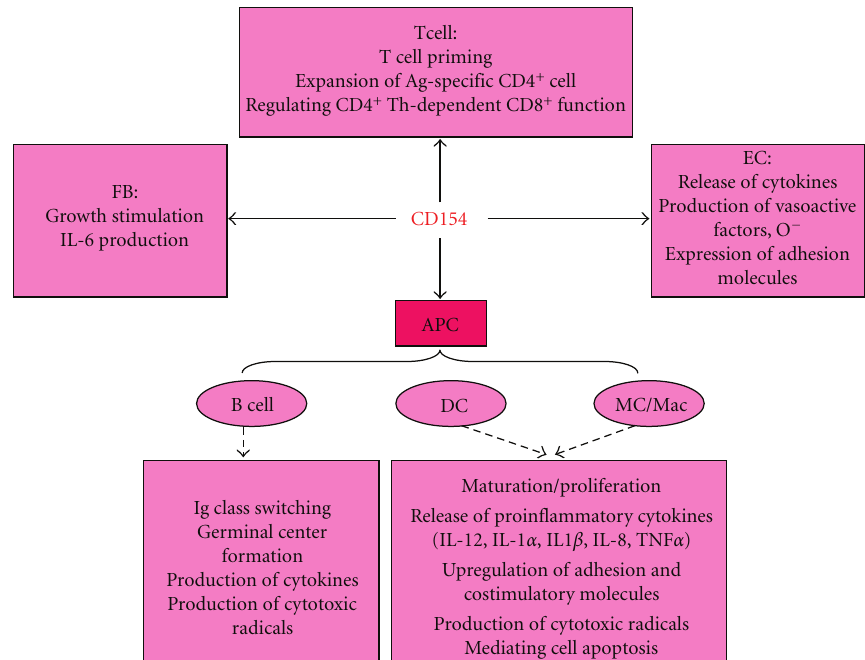
Figure 1: Biological function of the CD154/CD40 interaction. CD154 mediates numerous inflammatory functions on a wide variety of cell types by interacting with its classical CD40 receptor. These include T cell priming, B cell-dependent Ig class switching and germinal center formation, cell proliferation, regulation of apoptosis, release of proinflammatory cytokines, upregulation of adhesion molecules and costimulatory molecules, and production of cytotoxic radicals. FB: fibroblast, EC: endothelial cell, APC: antigen presenting cells, DC: dendritic cell, MC/Mac: